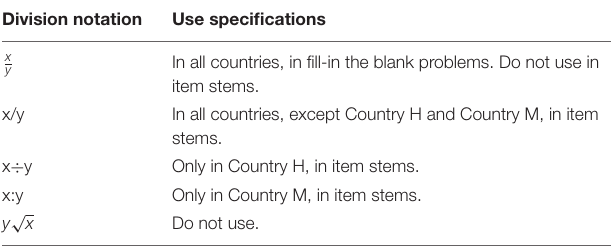
TABLE 3 | Use specifications for the design parameter, Division Notation in a hypothetical international mathematics test. Division notation